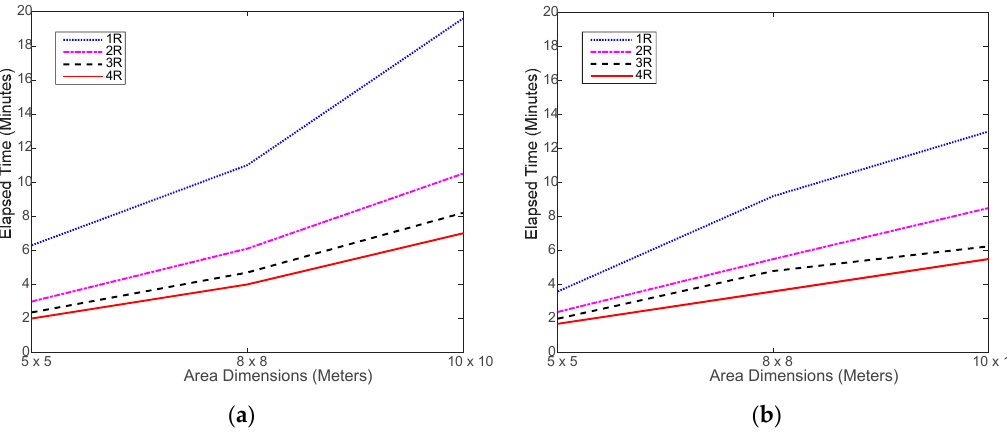
Figure 14. Enhanced simulated elapsed time after allowing the robot swarm to only cover 95% of the cells: ( a ) for distributed WiMAP algorithm; ( b ) for distributed DWiMAP.